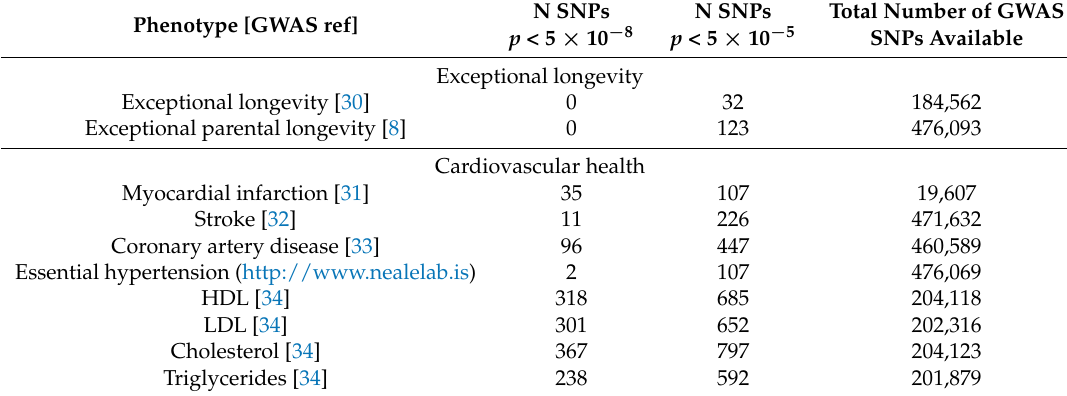
Table 2. Longevity and cardiovascular-related risk and disease phenotypes examined, with the number of single nucleotide polymorphisms (SNPs) included in each polygenic risk score (PRS) at two GWAS p -value cut-offs.